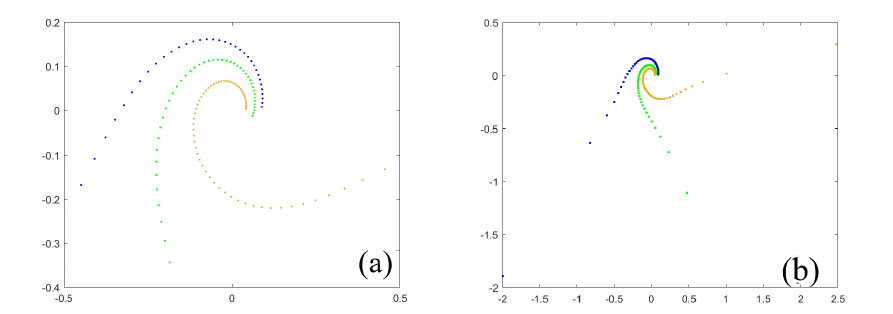
+ α + α 2 , β 2 ( α ) = 1 α 2 2 1